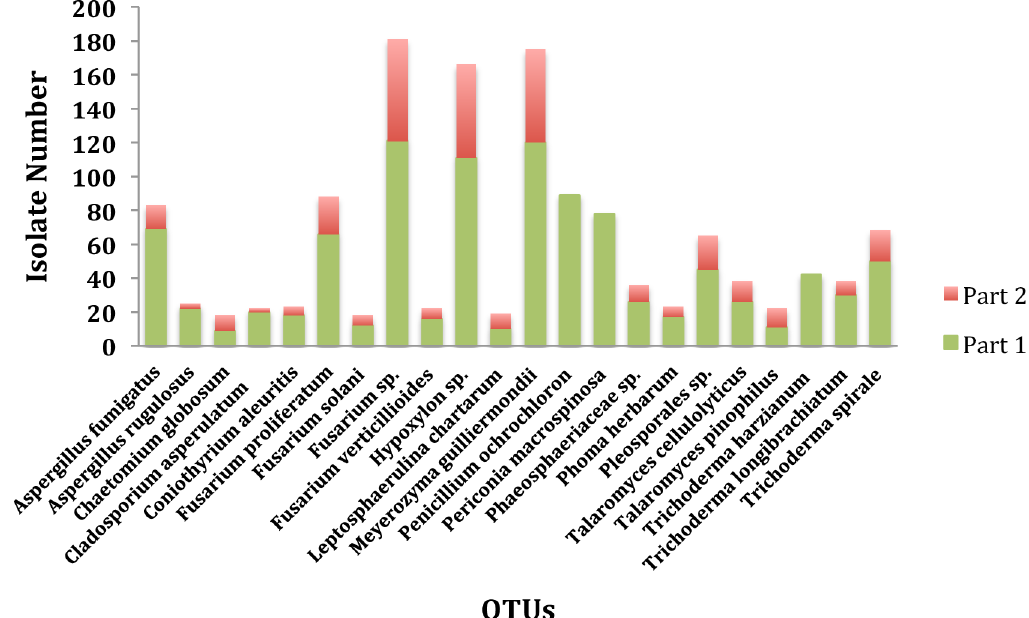
Fig 2. The distribution of endophytic fungi at species level between two locations on coal-mining site.